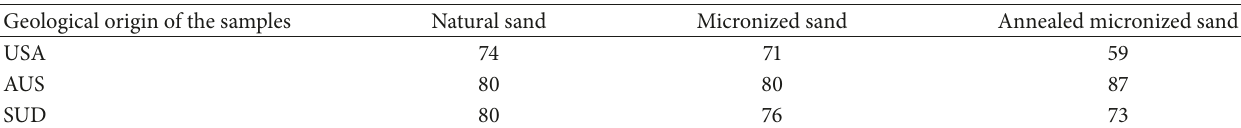
Table 4: Relative abundances representing the amount of PAC probes in the bridge region ( 𝑓 2 ) relative to all the PAC probes in the metamict region ( 𝑓 2 + 𝑓 4 ).